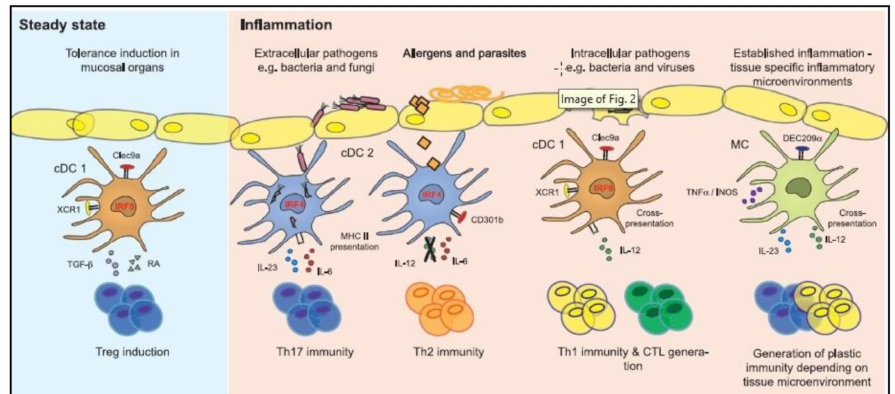
Figure 3. Diagram showing the functional characteristics of cDC subsets and monocyte-derived cell subsets in terms of their capacity to activate T cells during inflammation and the steady state. Reproduced with permission from [49]. Copyright 2015,